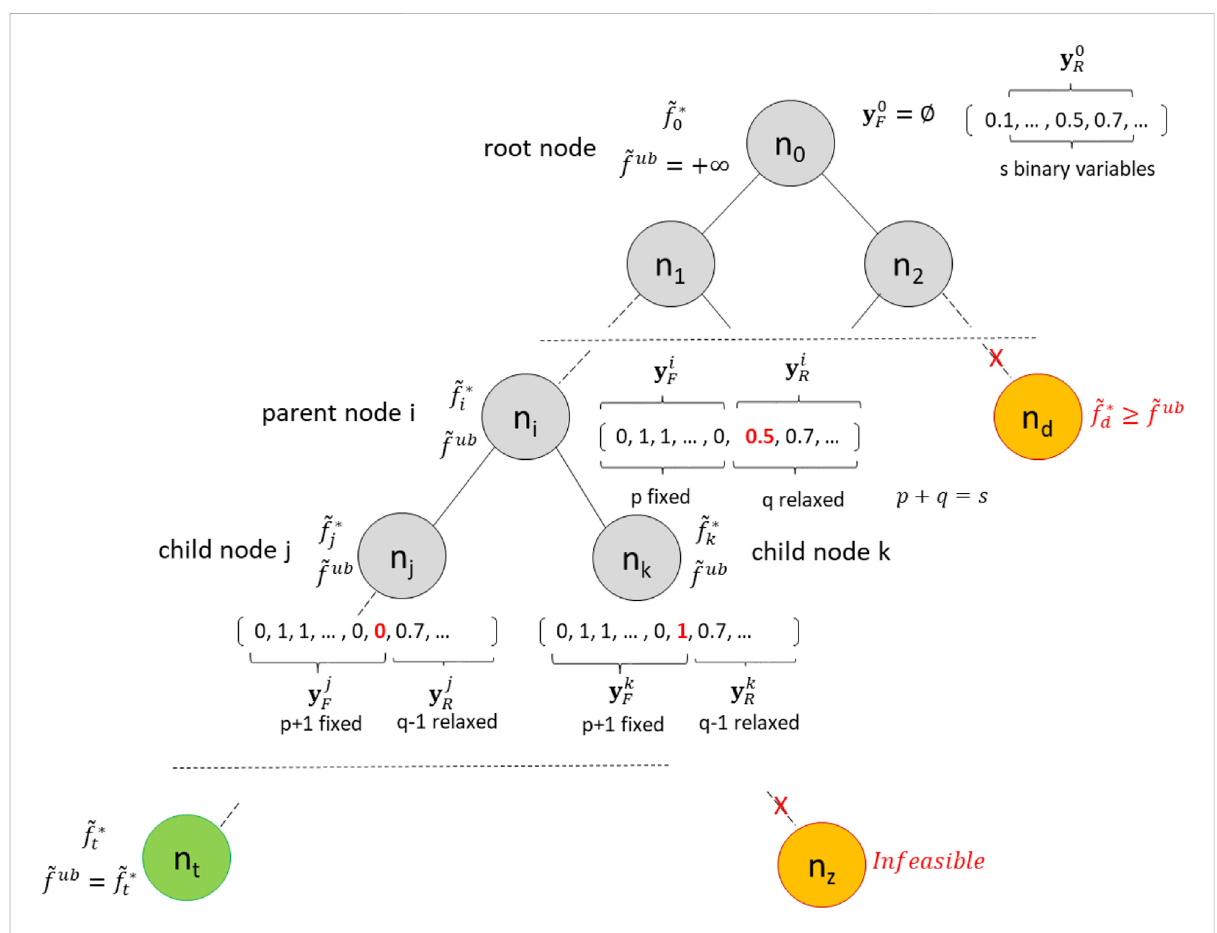
FIGURE 3 FPBB branch and bound search